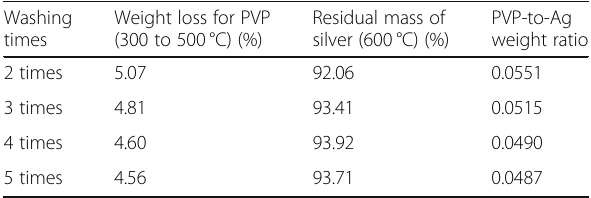
Table. 1 Analysis data according to TGA curves of Ag NP suspension of